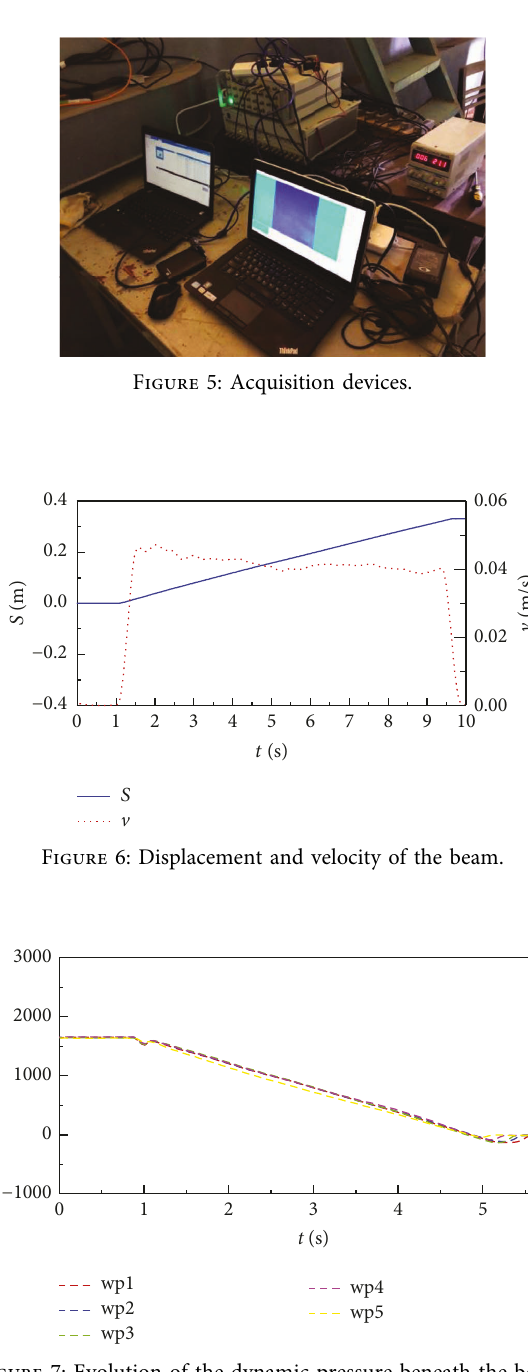
Figure 7: Evolution of the dynamic pressure beneath the beam.